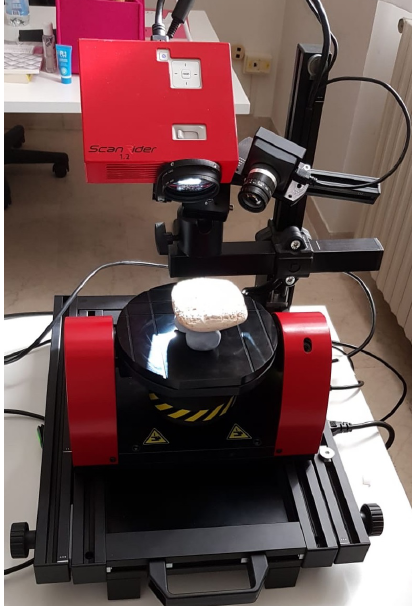
Figure 3: 18-55 mm, 100 mm and 50 mm lenses for the Canon EOS 1200D camera Figure 4: The ScanRider 1.2 by VGER in